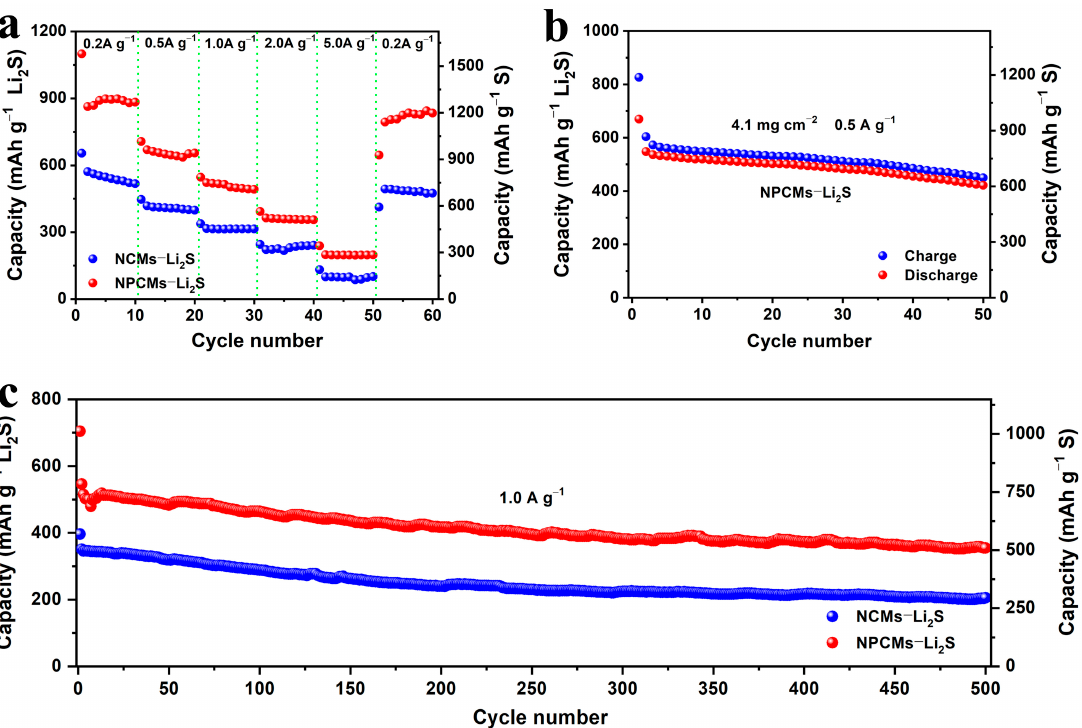
Figure 5. ( a ) Rate performance of NPCMs–Li 2 S and NCMs–Li 2 S electrodes; ( b ) cycling performance of the NPCMs–Li 2 S cathode at 0.5 A g − 1 with a mass loading of 4.1 mg cm − 2 ; ( c ) long-term cycle life of NPCMs–Li 2 S and NCMs–Li 2 S electrodes at 1.0 A g − 1 .